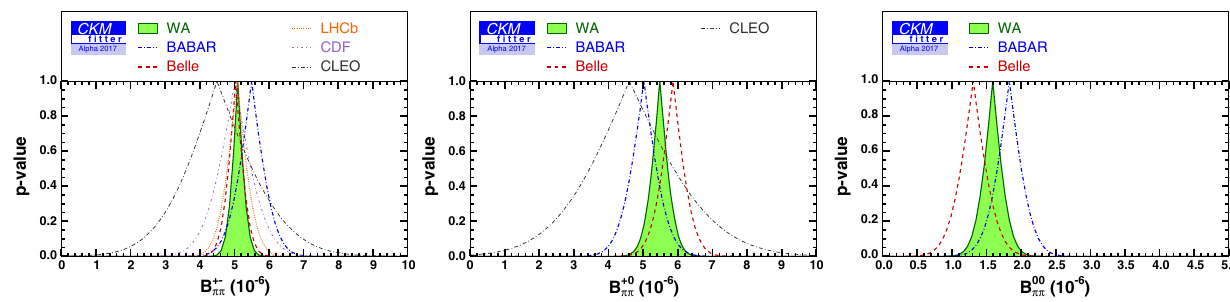
Fig. 42 Measurements of the B → ππ branching fractions from BaBar ( blue curve ) and Belle ( red curve ). When available, other experimental contributions are shown: LHCb ( orange ), CDF ( purple ) and CLEO ( black ). The green shaded area represents the world average